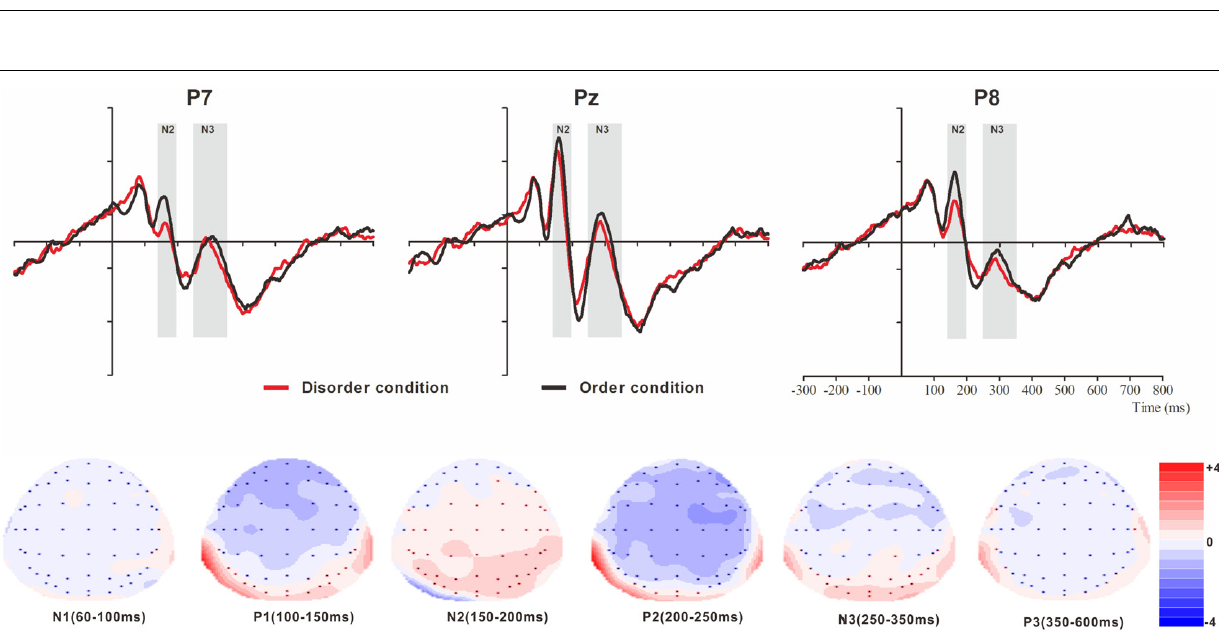
FIGURE 3 | Top: Average ERP waveforms at posterior P7, Pz, and P8 electrodes elicited by centrally presented basic visual disorder (red line) or order (black line) pictures. The significant differences between the disorder and order conditions are indicated by the gray (negative differences) rectangles, respectively. Time = 0 ms indicates the stimulus onset. Bottom: Topographic maps of the mean voltage amplitudes for the difference waveforms (disorder condition minus order condition) matched to the time window of each component elicited by the stimuli (notably the posterior locations). Increased negativity is shown in blue, and increased positivity is shown in